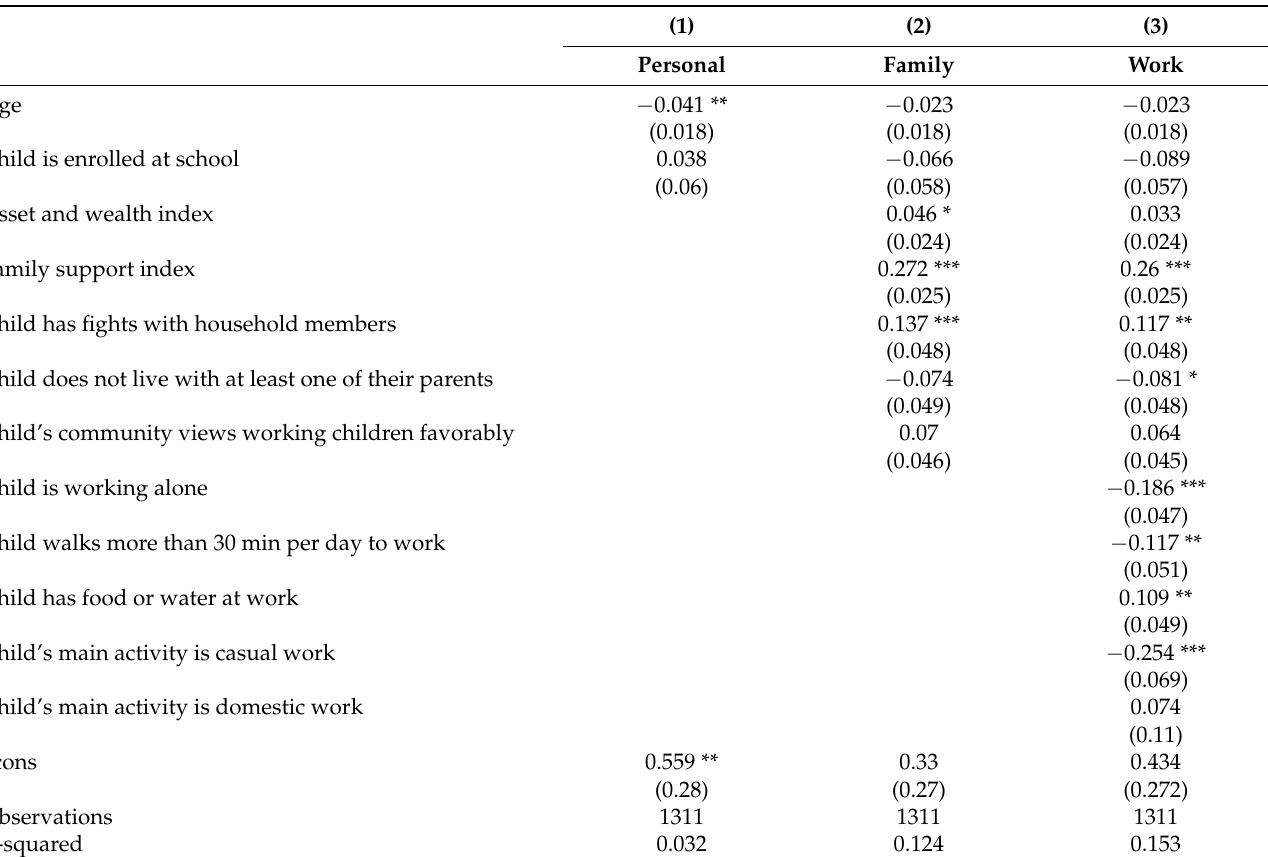
Table A8. Linear regressions for supervision